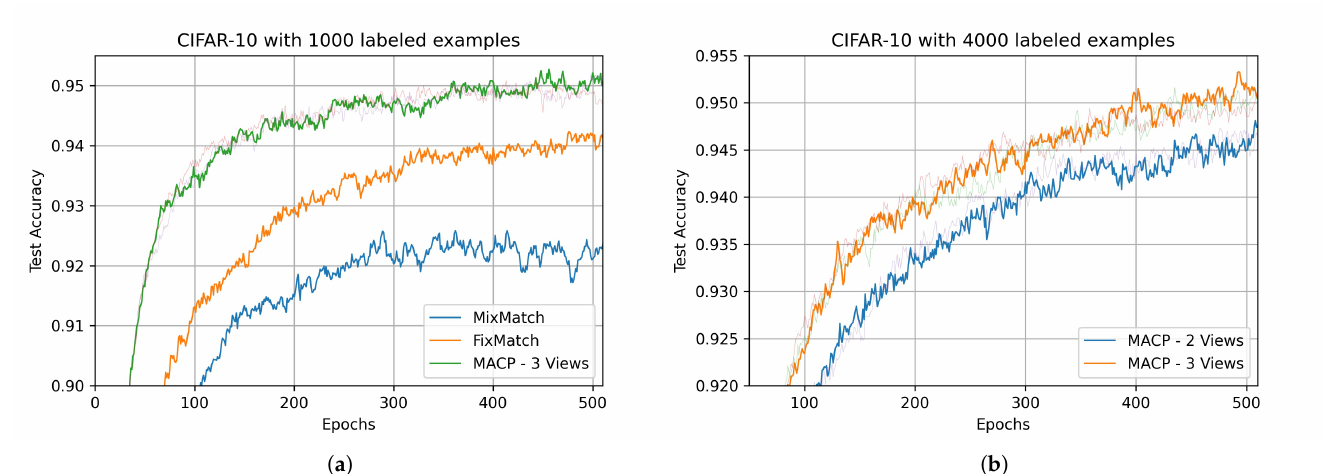
Figure 4. Performance comparison of MACP with different methods and different number of views during training. ( a ) Performance comparison for MixMatch, FixMatch and MACP on CIFAR-10-1000- label experiment; ( b ) Performance comparison for 2-view and 3-view MACP on CIFAR-10-4000-label